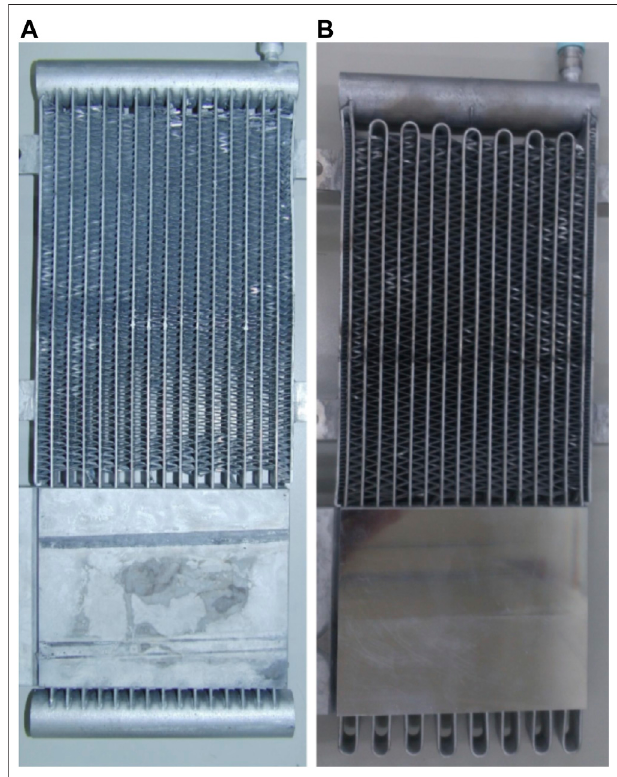
FIGURE 5 | Schematic diagram of (A) thermosyphon heat exchanger and (B) pulsating heat pipe heat exchanger (Daraghmeh and Wang, 2017).